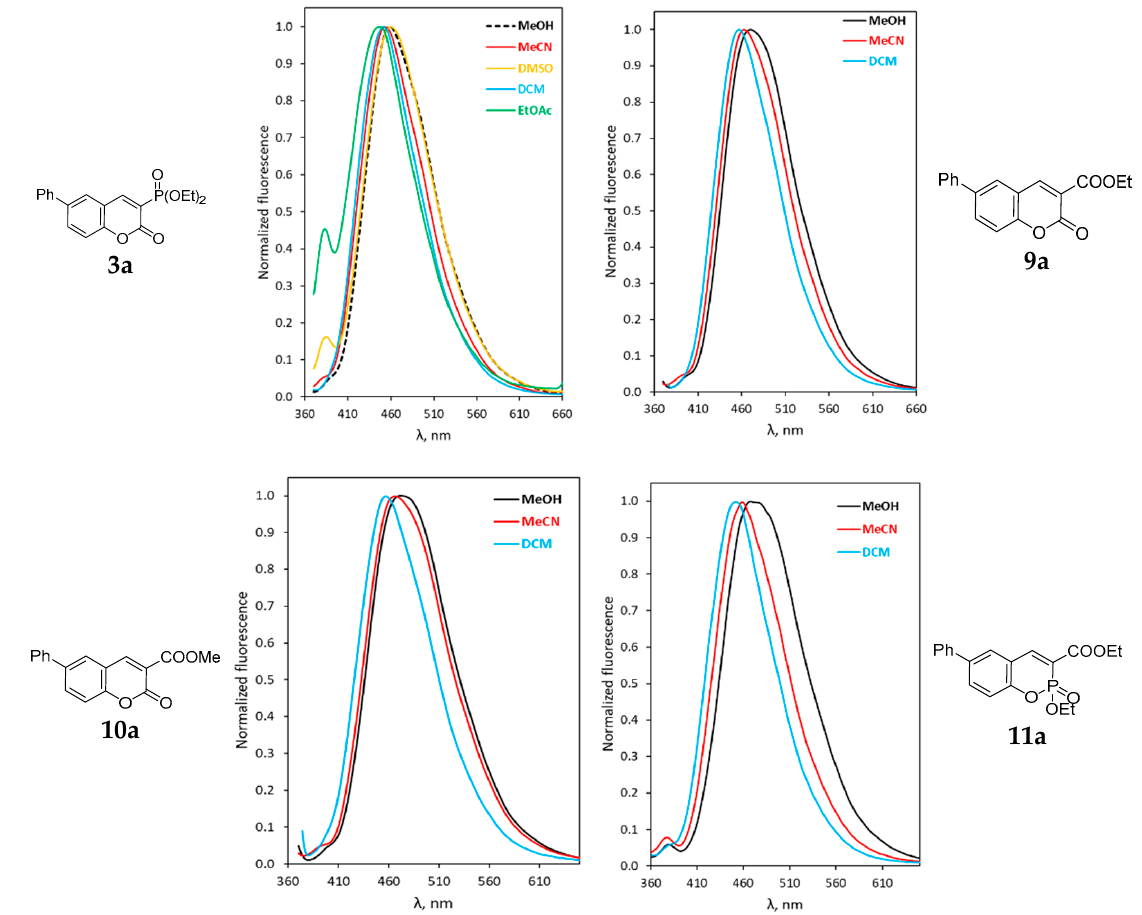
Figure 3. Normalized fluorescent spectra of the phenyl substituted derivatives.